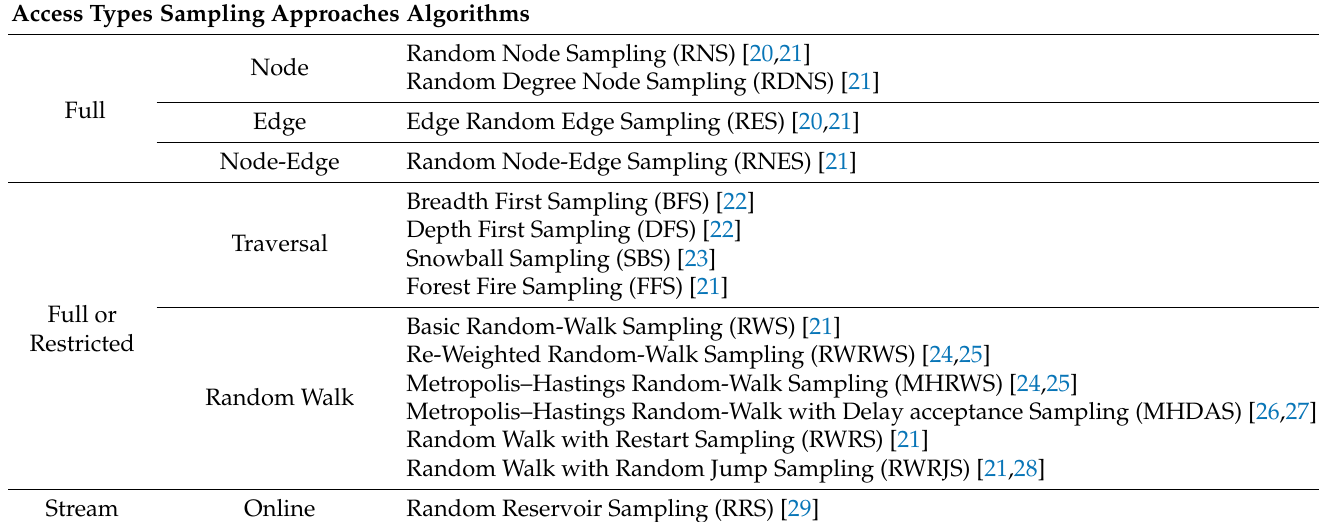
Table 2. Representative network sampling